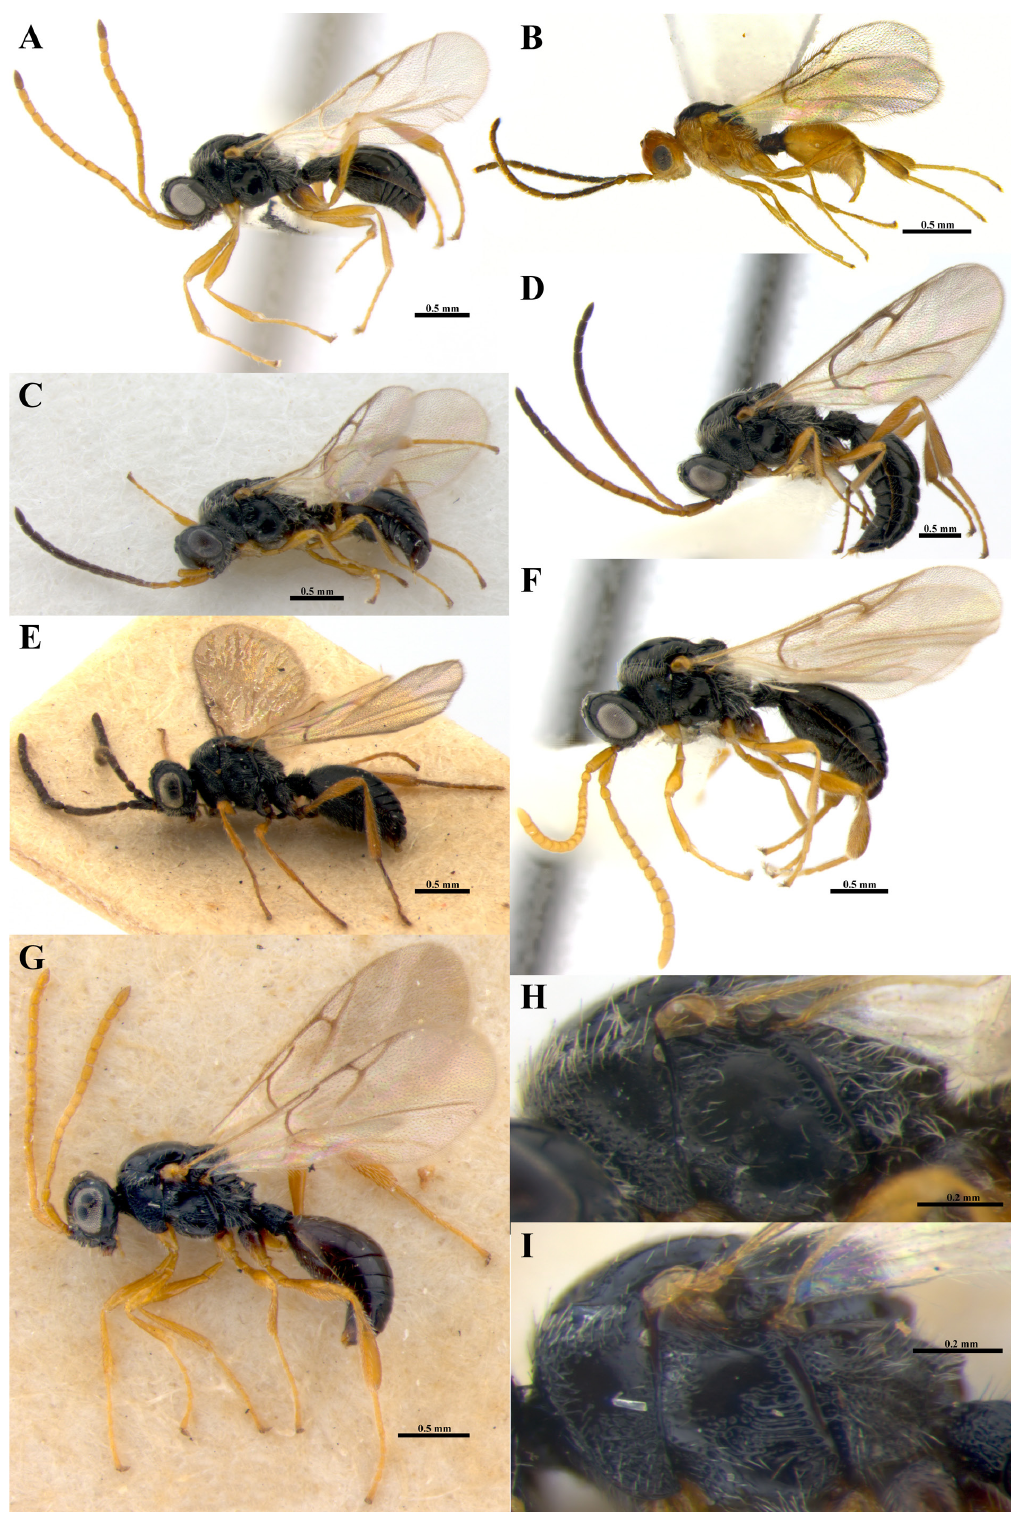
Fig. 1. Ismarus spp., ♀♀ (A–G. Habitus; H–I. Mesosoma in lateral view). A . I . apicalis Kolyada & Chemyreva, 2016. B . I . dorsiger (Haliday, 1831). C , H . I . halidayi Förster, 1850. D . I . grandis Alekseev, 1978. E . I . rugulosus Förster, 1850. F . I . spinalis Kolyada & Chemyreva, 2016. G , I . I . flavicornis (Thomson,